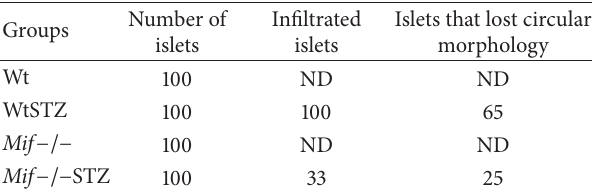
Table 1: Assessment of the extent of leukocyte infiltration into pancreatic islets of WT and Mif − / − mice at 8 weeks after STZ